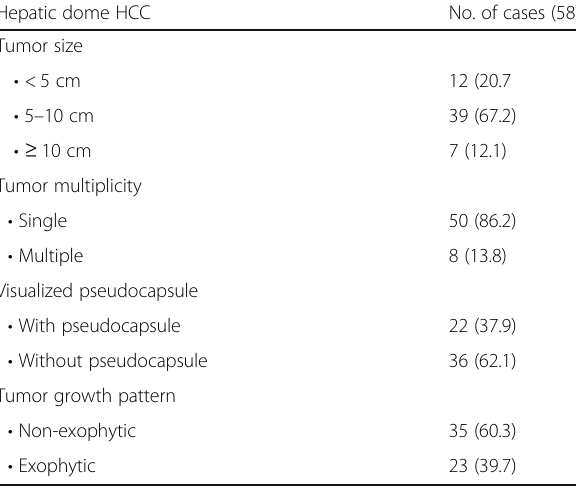
Table 1 The characteristics of hepatic dome HCCs at the initial MDCT examination in our studied